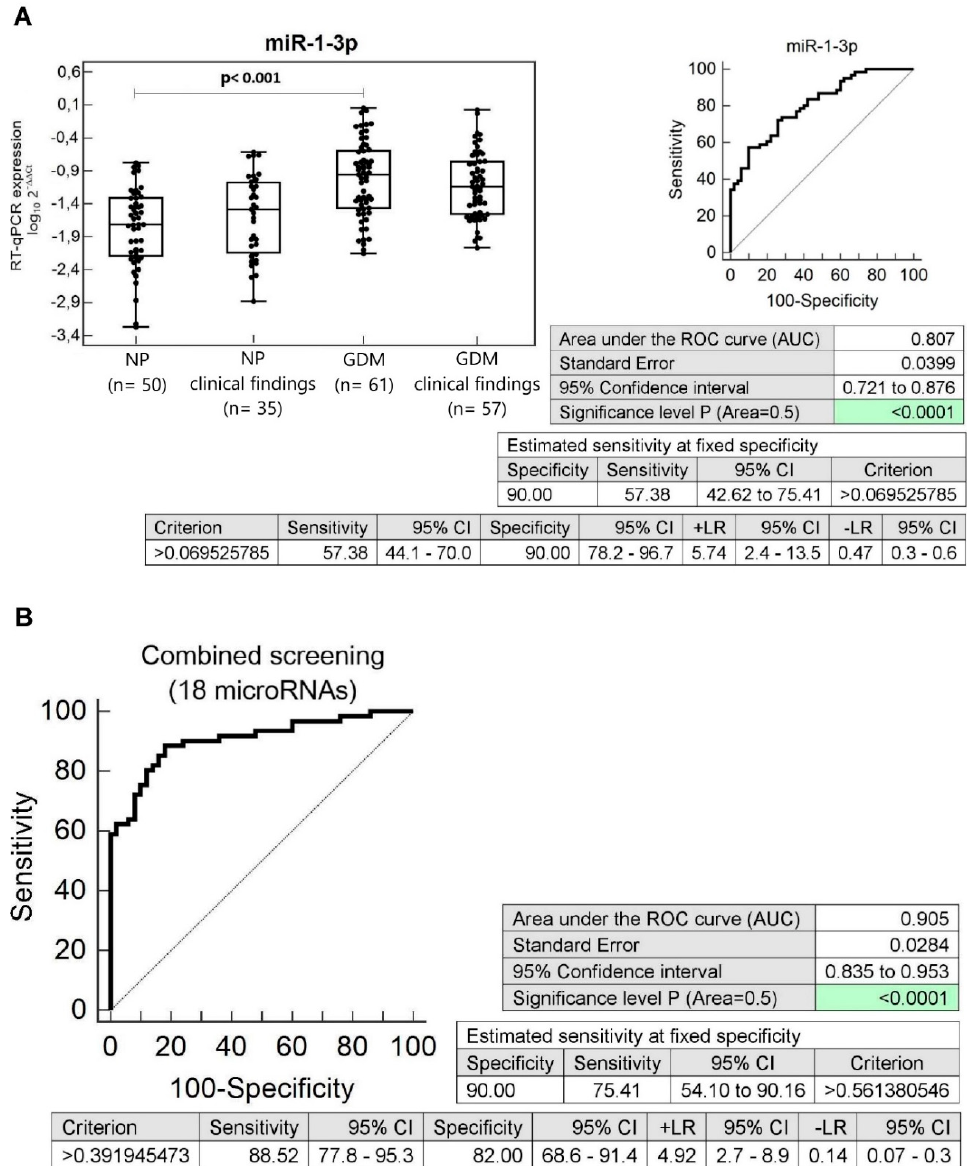
Figure 3. Aberrant microRNA expression profile in children descending from GDM complicated pregnancies with normal clinical findings. ( A ) Upregulation of miR-1-3p was observed in children descending from GDM complicated pregnancies with normal clinical findings, when the comparison to the controls with normal clinical findings was performed. Concerning individual microRNAs, miR-1-3p showed the highest accuracy for the identification of children at a higher risk of later development of diabetes mellitus and/or cardiovascular/cerebrovascular diseases. ( B ) Combined screening of microRNAs in the identification of children prenatally exposed to GDM with normal clinical findings at an increased risk of later development of diabetes mellitus and / or cardiovascular / cerebrovascular diseases. Screening based on the combination of microRNAs with a good sensitivity (miR-1-3p, miR-17-5p, miR-20a-5p, miR-20b-5p, miR-21-5p, miR-23a-3p, miR-29a-3p, miR-100-5p, miR-103a-3p, miR-125b-5p, miR-126-3p, miR-133a-3p, miR-143-3p, miR-181a-5p, miR-195-5p, miR-221-3p, miR-499a-5p, and miR-574-3p) showed the highest accuracy for the identification of children prenatally exposed to GDM with normal clinical findings at a higher risk of later development of diabetes mellitus and / or cardiovascular / cerebrovascular diseases. The comparison to the controls with normal clinical findings was performed. NP: Normal pregnancies; GDM: Gestational diabetes